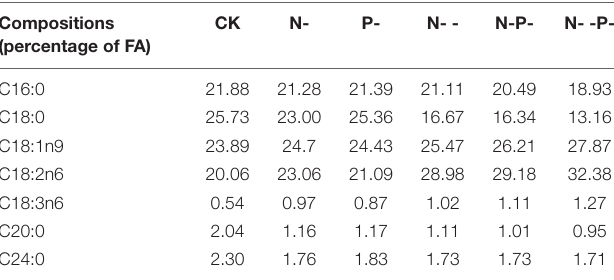
TABLE 2 | Effects of nitrogen and phosphorus limitation on main FA composition and percentage of Aspergillus oryzae . Compositions (percentage of